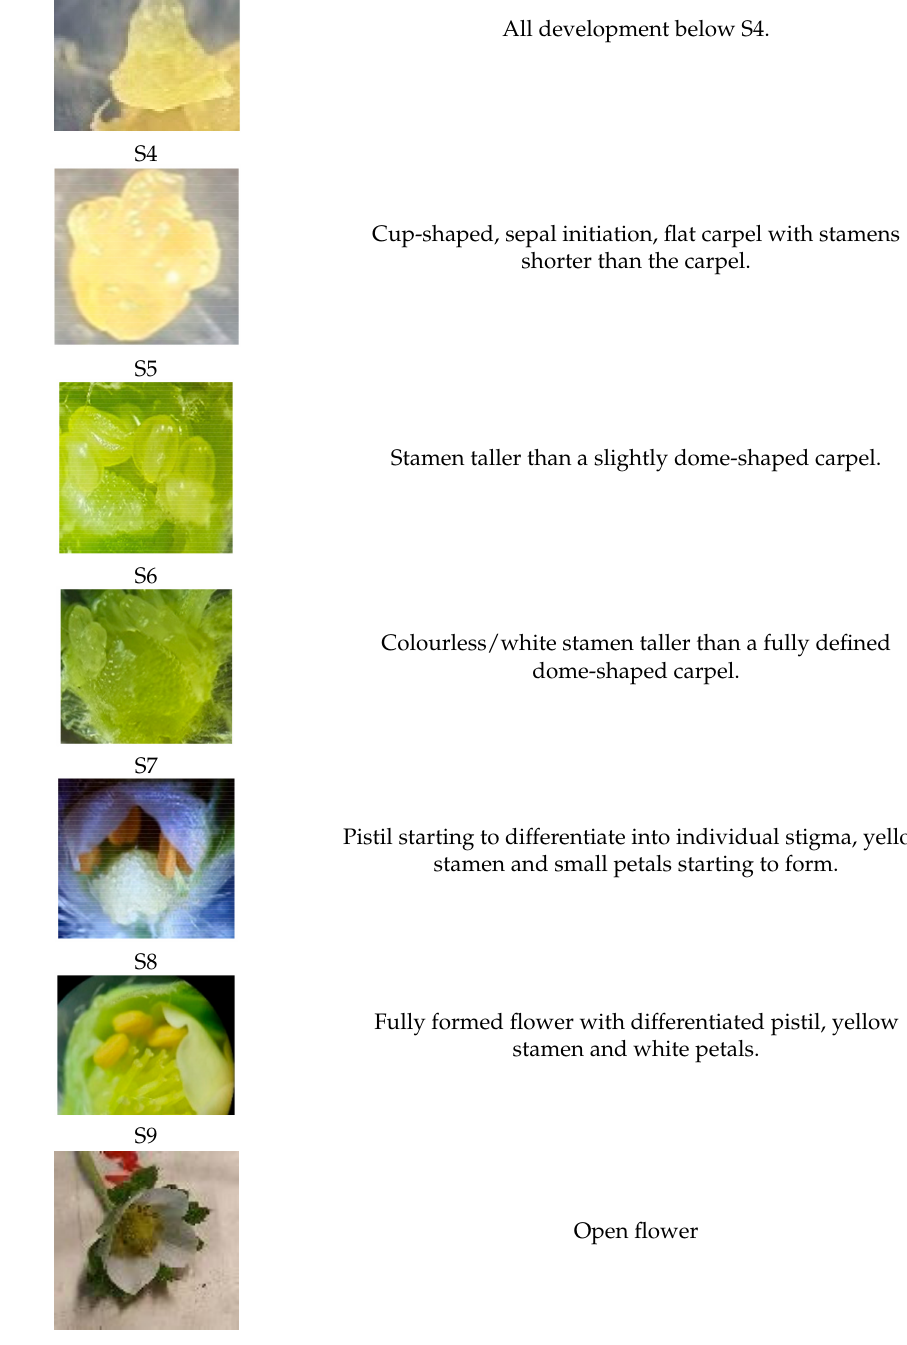
Table 2. Description of floral developmental stages (S3 to S9) for strawberry plants assessed under a stereo light microscope. Stages below S4 were regarded as vegetative, while stages from 4 to 9 were regarded as